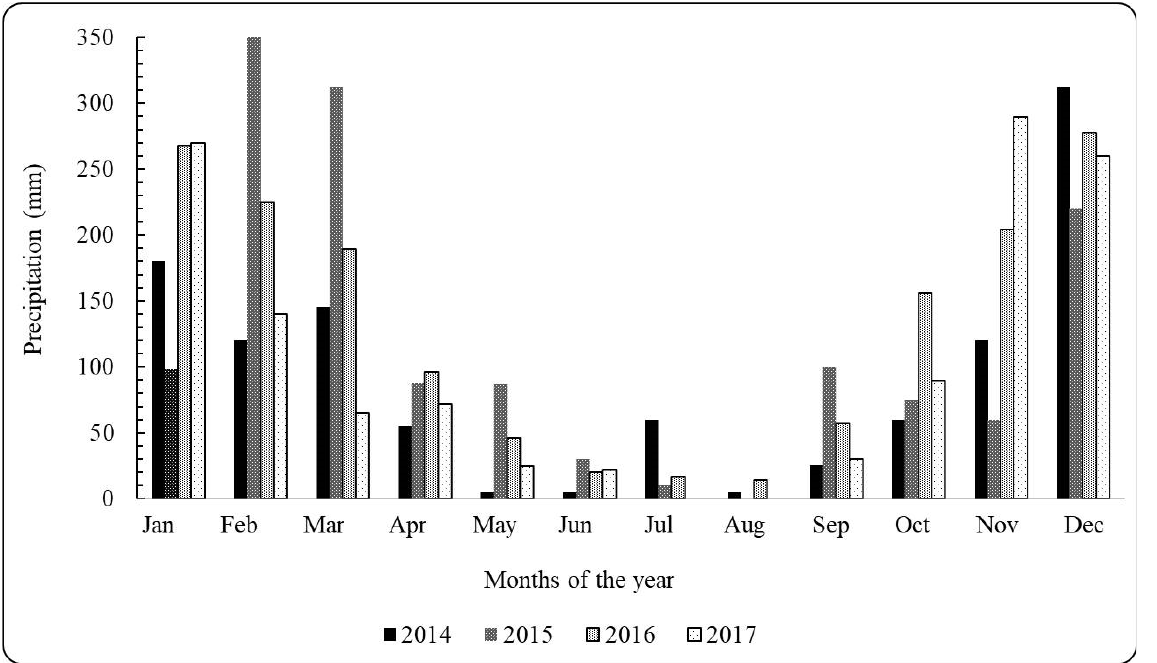
Figure 1. Monthly rainfall depths in 2014, 2015, 2016, and 2017 in Uberaba, MG, Brazil. Source: Adapted from Inmet [28].